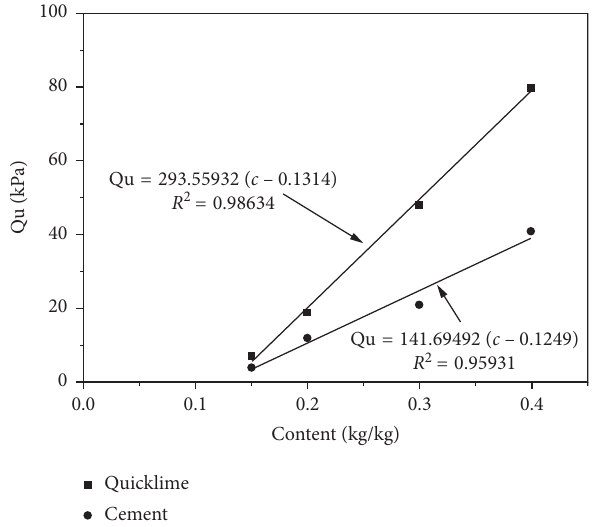
Figure 2: Relationship of the specimen strength versus cement and quicklime